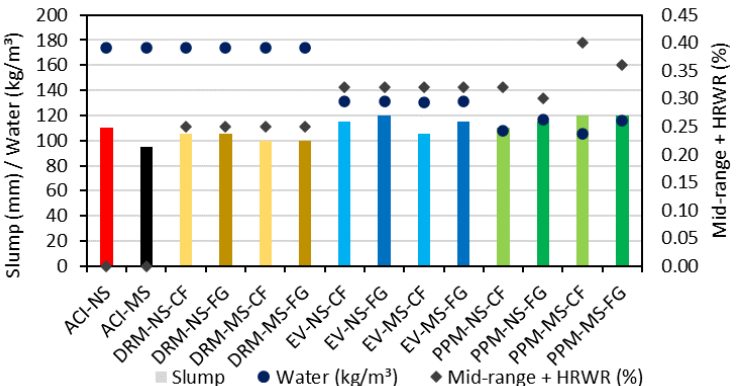
Figure 5. Comparison between slump, water content and admixtures of distinct